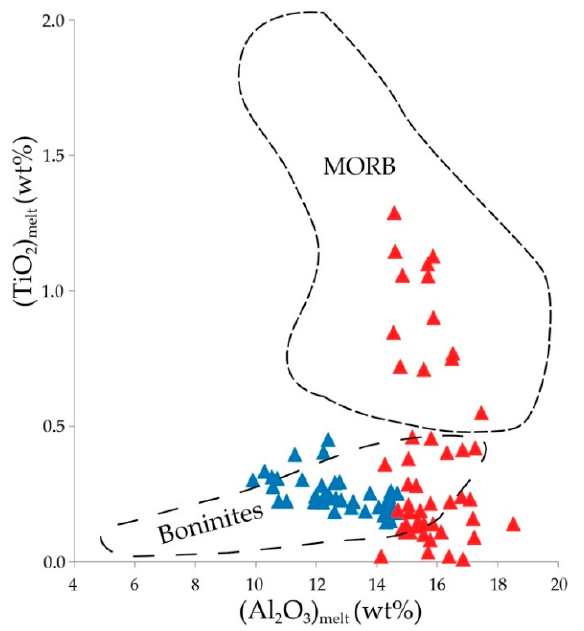
Figure 14. Al 2 O 3melt vs. TiO 2melt of the melt calculated as in equilibrium with chromite from samples. Fields for boninites and MORB (Mid Ocean Ridge Basalts) (after [82]).